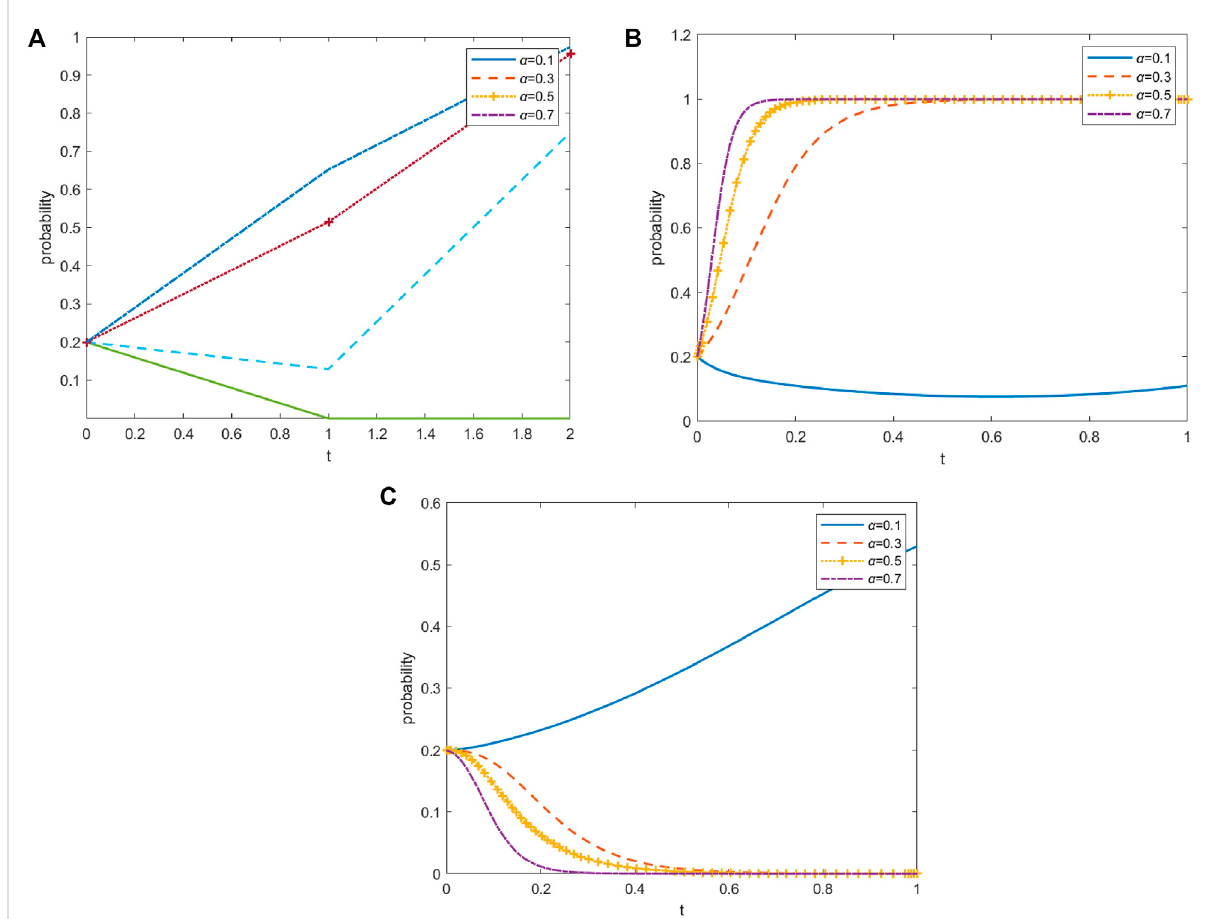
FIGURE 9 Effectof α ontheevolutionofthesystem. (A) Effectof α onfarmer ’ sstrategy, (B) Effectof α onthelocalgovernment ’ sstrategy, (C) Effectof α on the central government ’ s